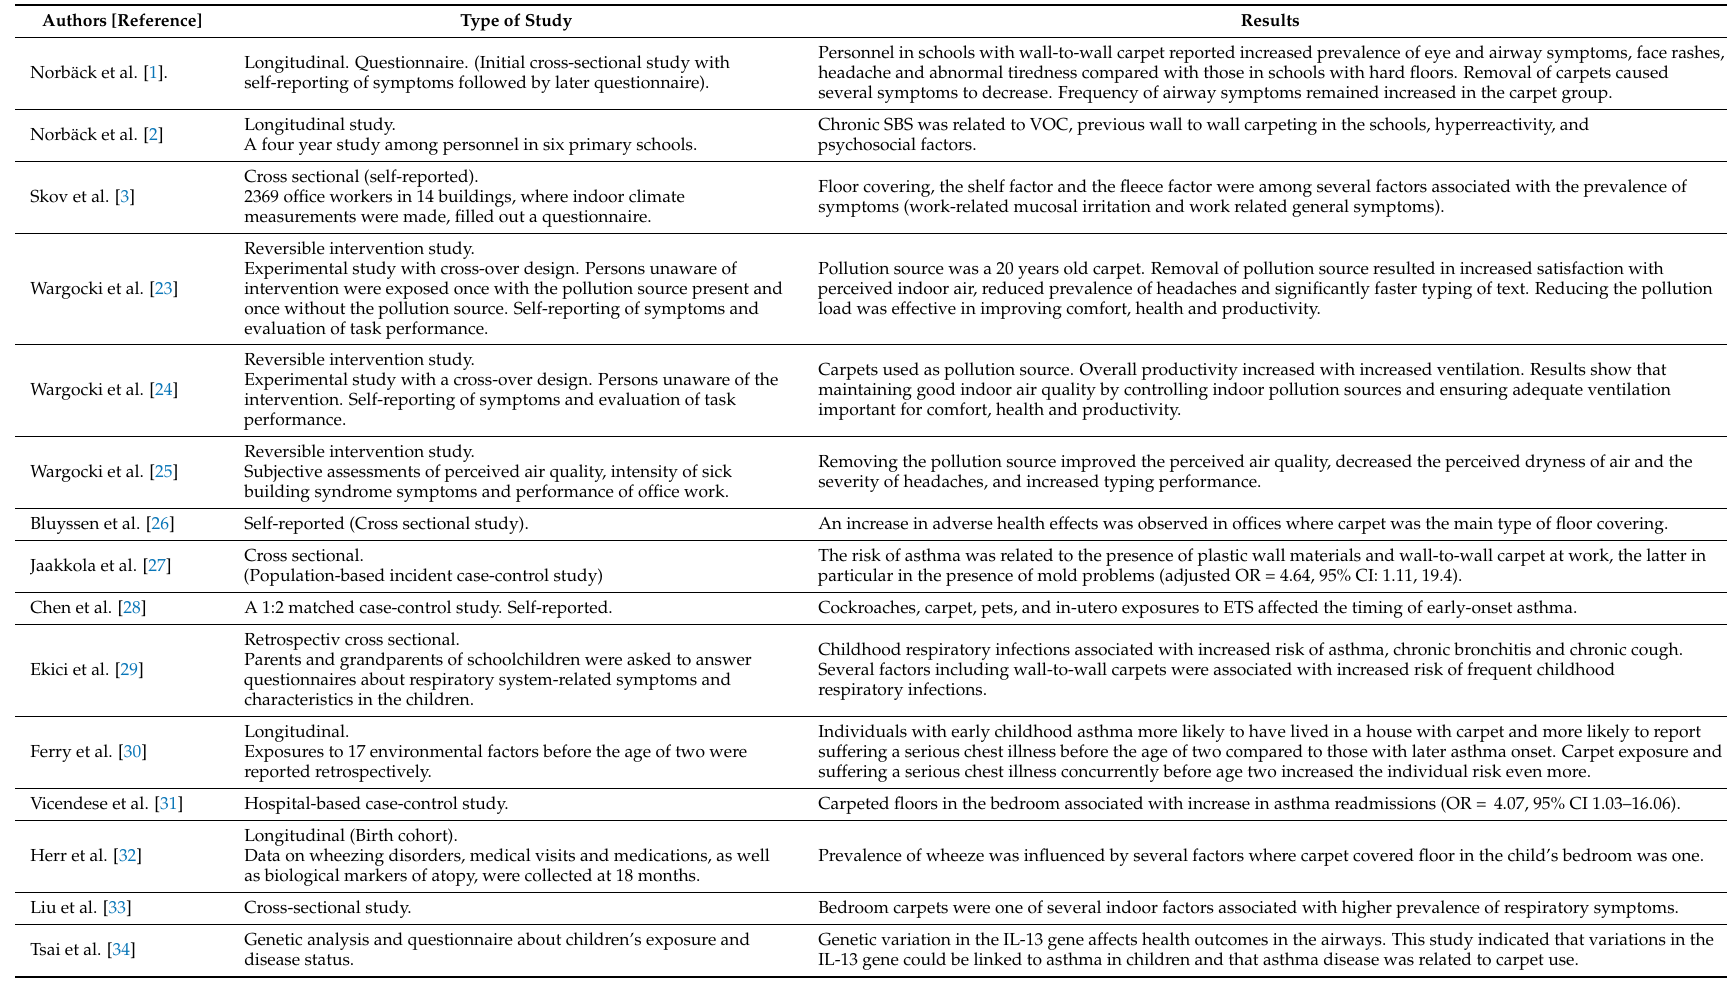
Table 2. Associations between carpet use and adverse health